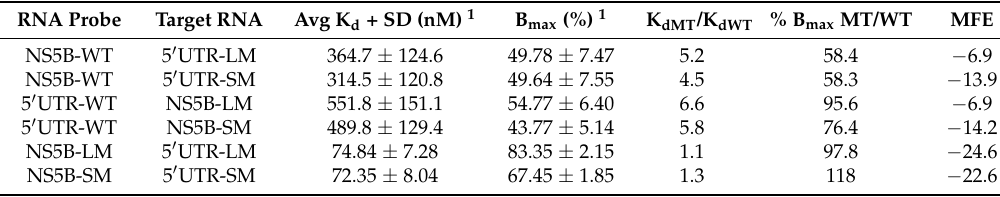
Figure 3. In vitro complex between 5’UTR nt 1–290 and NS5B nt 8374-8676 RNAs containing six and five mutations (LM) or two mutations (SM) in the 5’UTR nt 95–110 (•) or NS5B nt 8528-8543 ( ◦ ). 32 P-labeled RNA probe (20 nM) was incubated with two-fold increasing amounts of unlabeled RNA target (six lane gels = 0, 50, 100, 200, 400, 1000 nM) or (five lane gels = 0, 50, 100, 200, 400 nM) in low magnesium binding buffer. Plots of % probe complex versus target concentration ± SE were derived from three separate experiments and used to calculate K d and B max values as summarized in Table 1. TABLE 1. Binding variables of the 5’UTR–NS5B RNA interaction.